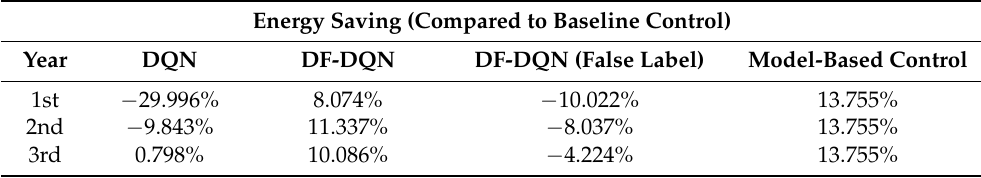
Table A1. Energy-saving effect of each method compared with baseline